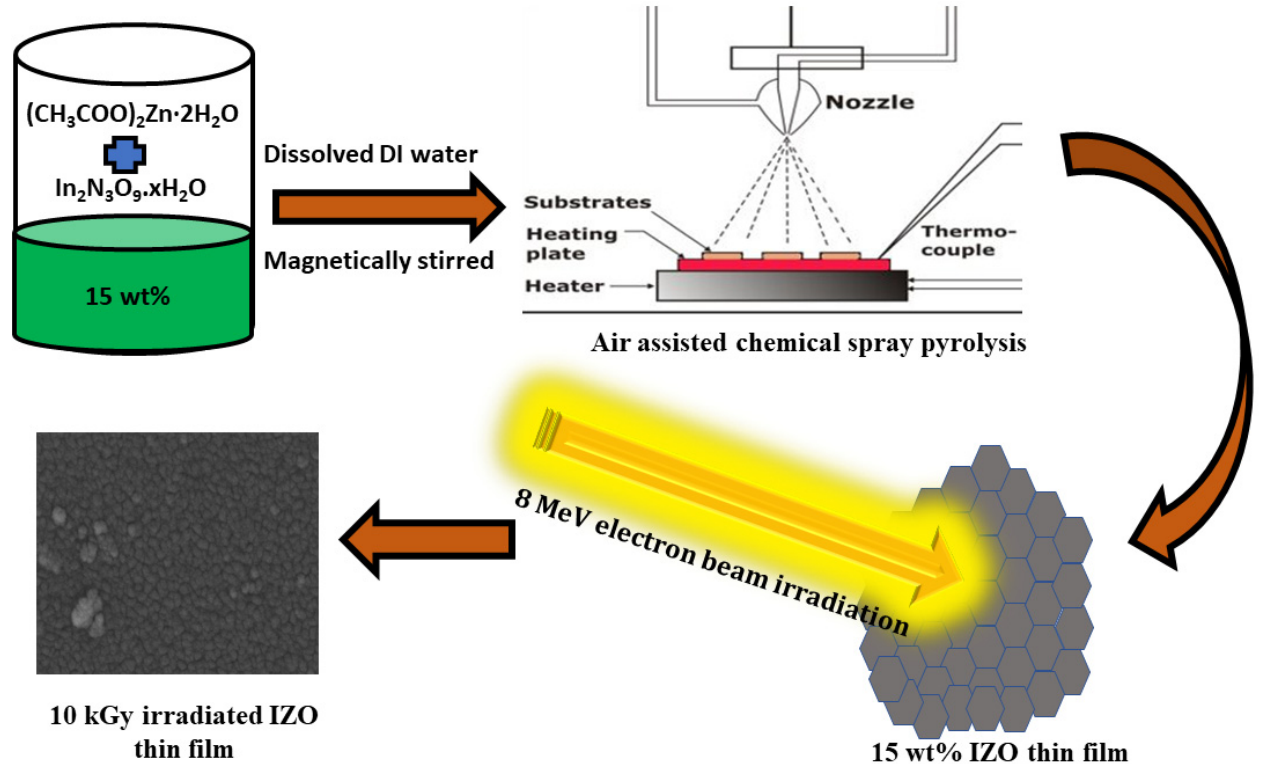
Figure 1. Schematic of IZO thin films preparation and electron beam